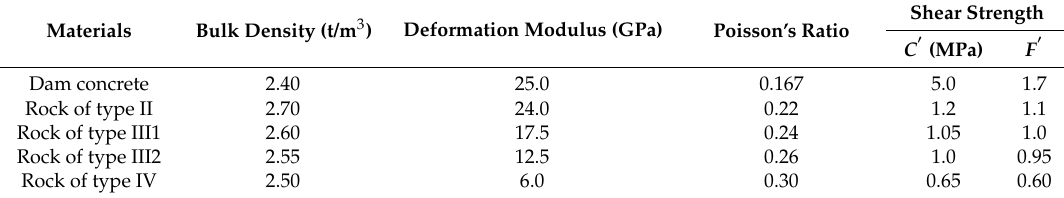
Figure 6. The 3D numerical model. ( a ) dam-foundation overall model; ( b ) main faults distribution. Table 2. Physical–mechanical parameters of the rock masses and dam materials.